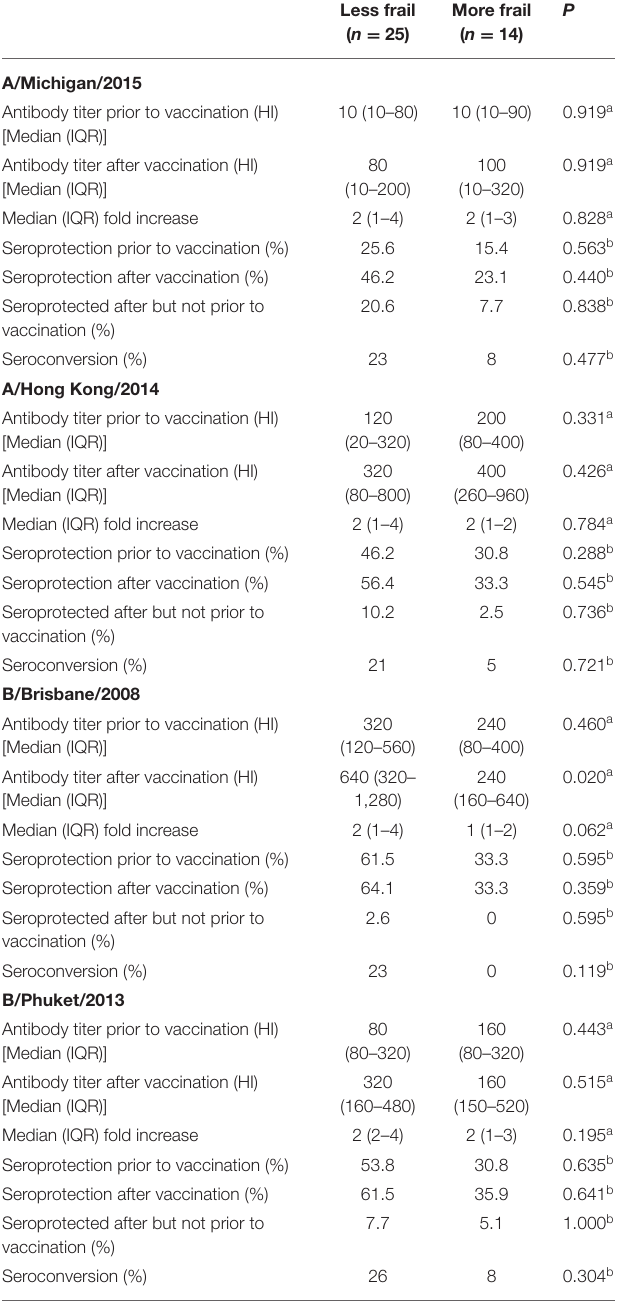
TABLE 4 | Anti-seasonal influenza antibody titres, seroprotection and seroconversion in participants according to frailty.